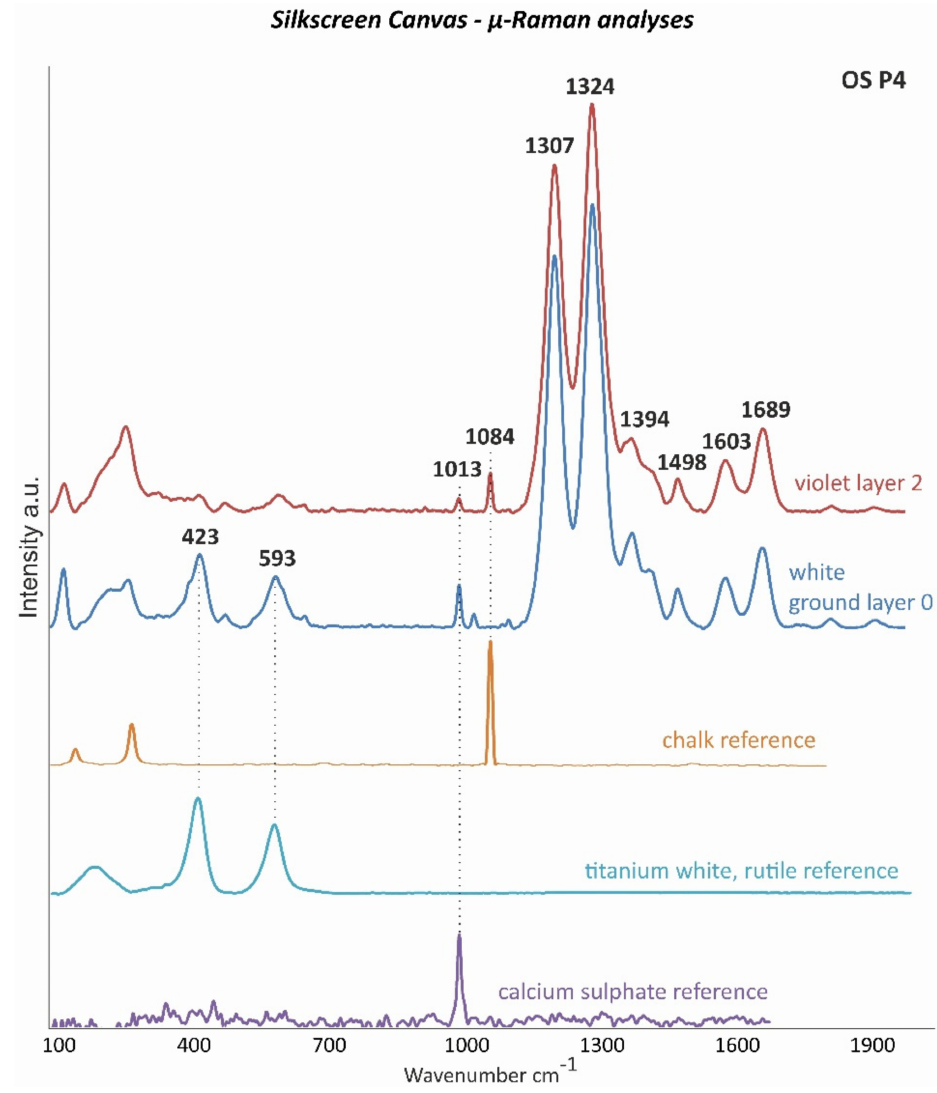
Figure 12. µ -Raman spectra of the white ground layer 0 (blue line) and the violet layer 2 (red line) of OS P4 and of the calcium sulfate (CaSO 4 ) (violet line), titanium white, rutile (TiO 2 ) (light blue line), and chalk (CaCO 3 ) (orange line) references as the main detected components. Peaks at 1307, 1324, 1394, 1498, 1603, and 1689 cm − 1 were not